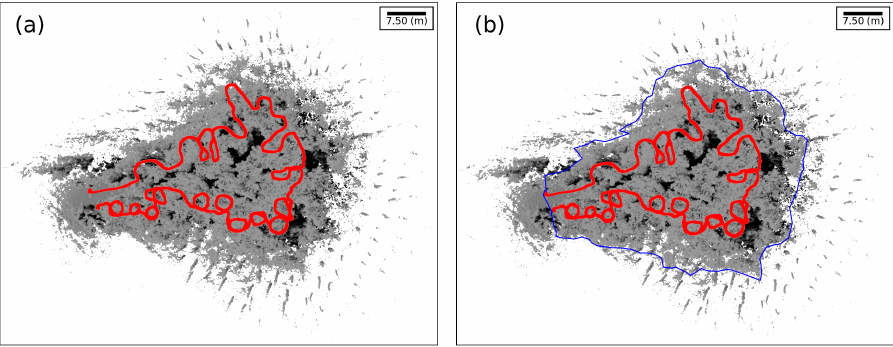
Figure 4. ( a ) Full original point cloud with trajectory marked in red color. ( b ) Polygon reconstruction from a trajectory’s convex hull in blue color.